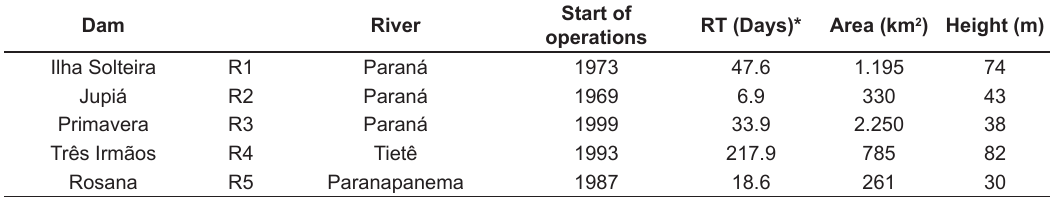
Table 1. Water residence time and morphometric characteristics of each reservoir (RT – residence time).